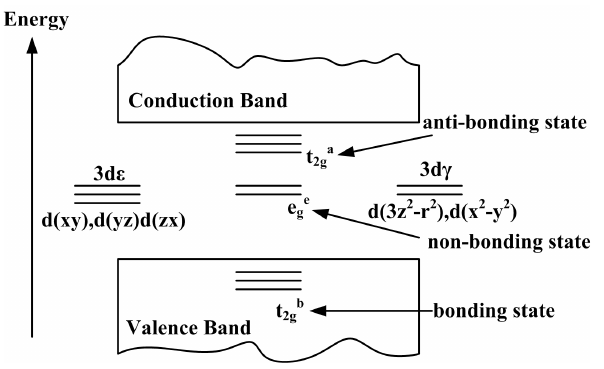
Figure 5. The energy graph of 3d TM atoms in a tetrahedral crystal field (T d ).